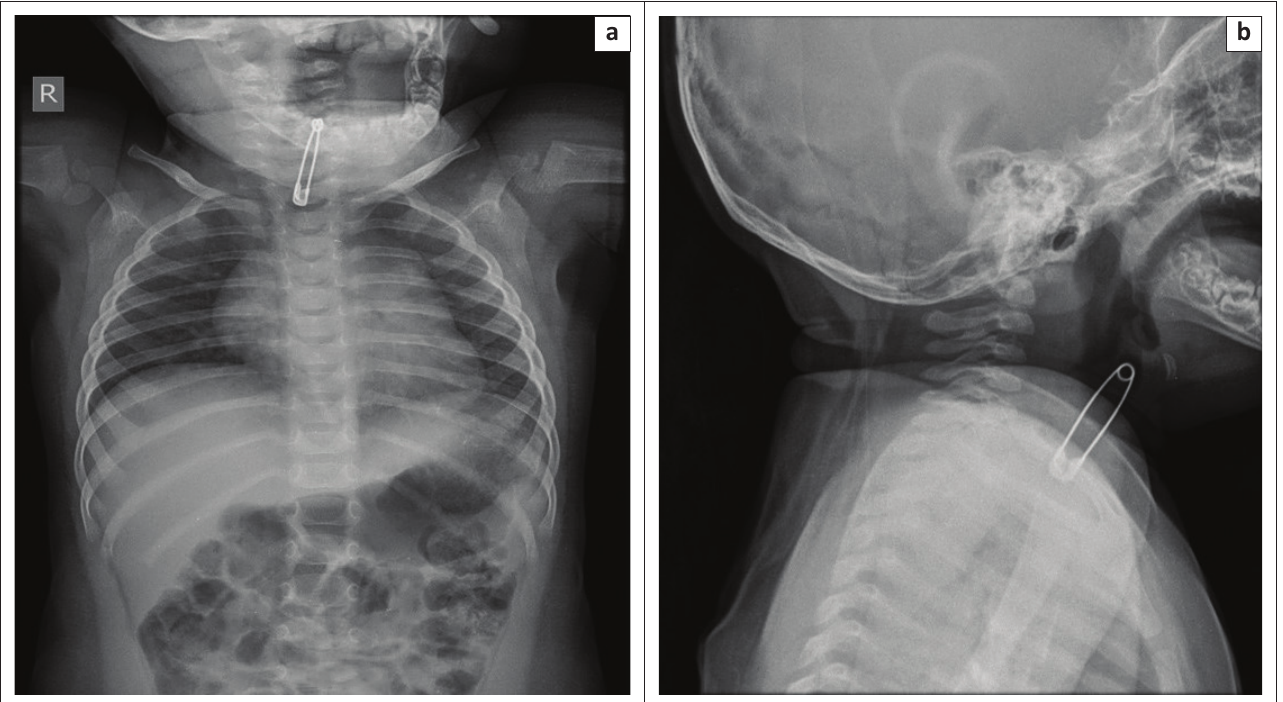
FIGURE 12: Frontal (a) and lateral (b) radiographs of the neck in a 2-year-old child with an aspirated safety pin in the subglottic